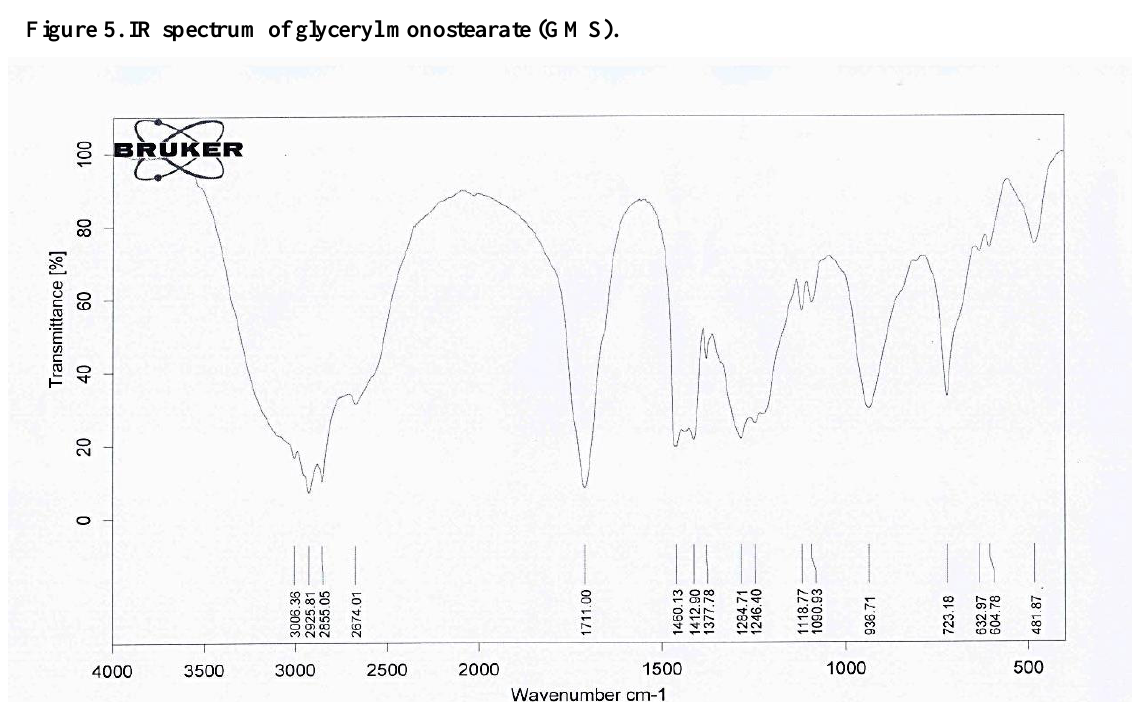
Figure 6 . IR spectrum of oleic